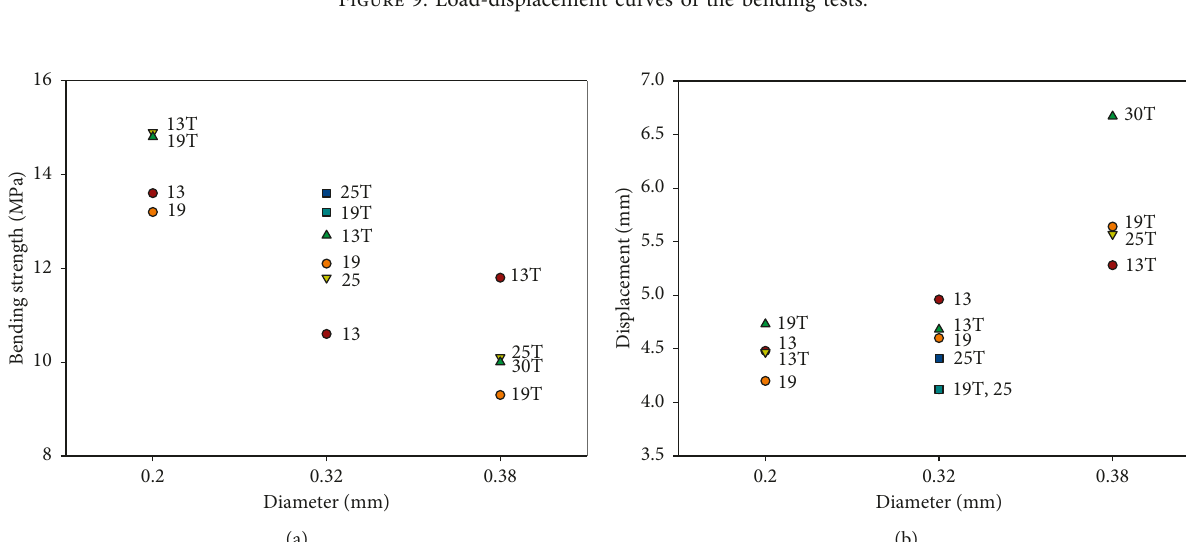
Figure 9: Load-displacement curves of the bending tests.